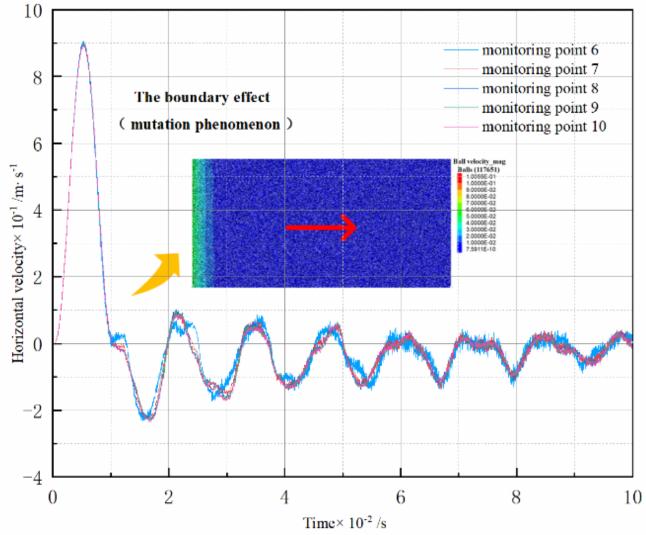
Figure 16. Monitoring curve of horizontal velocities